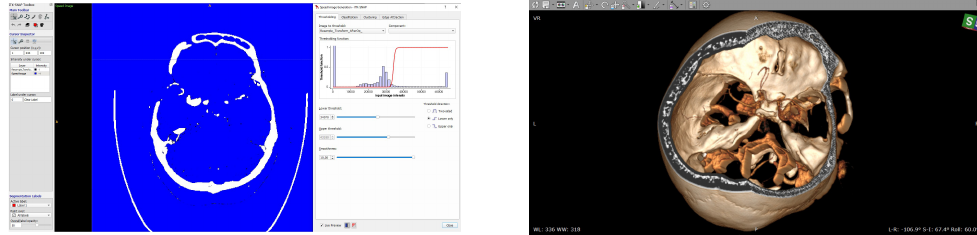
Figure 2. Vascular reconstruction methods: Image processing in the ITK-Snap program: DICOM image of the slice before the operation ( left ), Determination of the intensity threshold ( right ), Recon- struction of blood vessels in RadiAnt DICOM